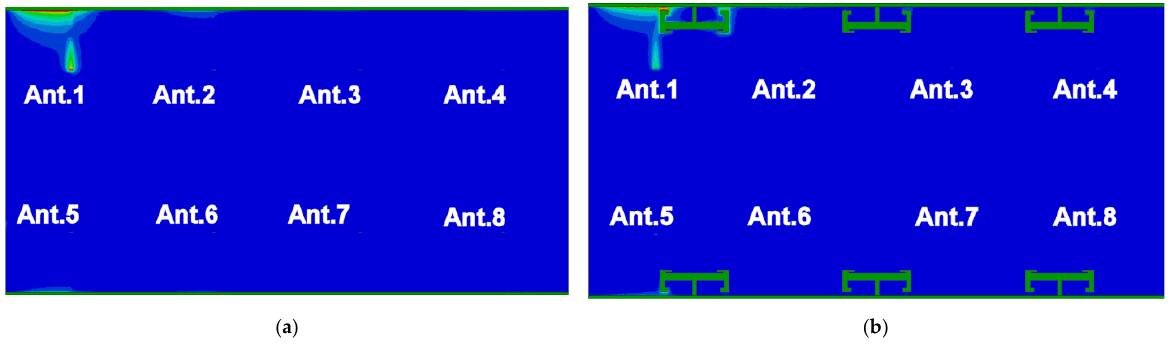
Figure 3. Antenna surface current distribution at 3.5 GHz with Ant.1 excited ( a ) with no decoupling element and ( b ) with the decoupling element.